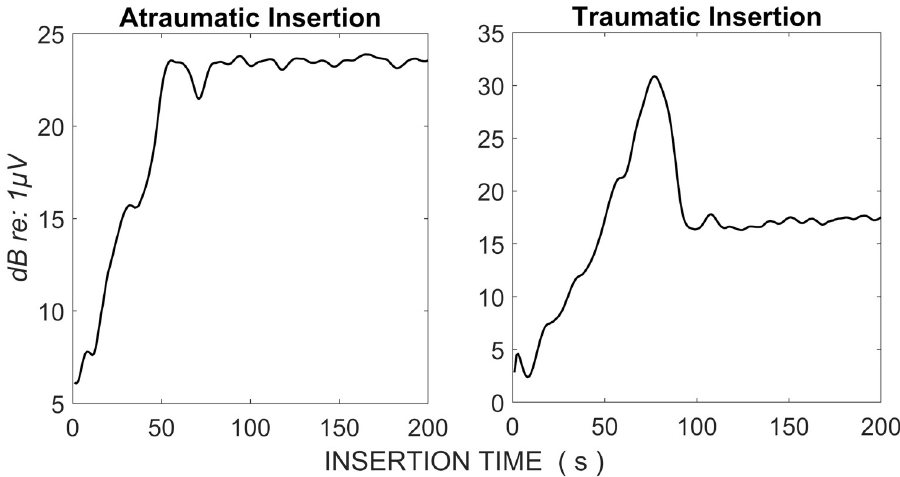
Fig 2. Changes in the cochlear microphonic for two patients with presumed electrophysiological evidence of atraumatic (left) and traumatic (right) CI insertions.